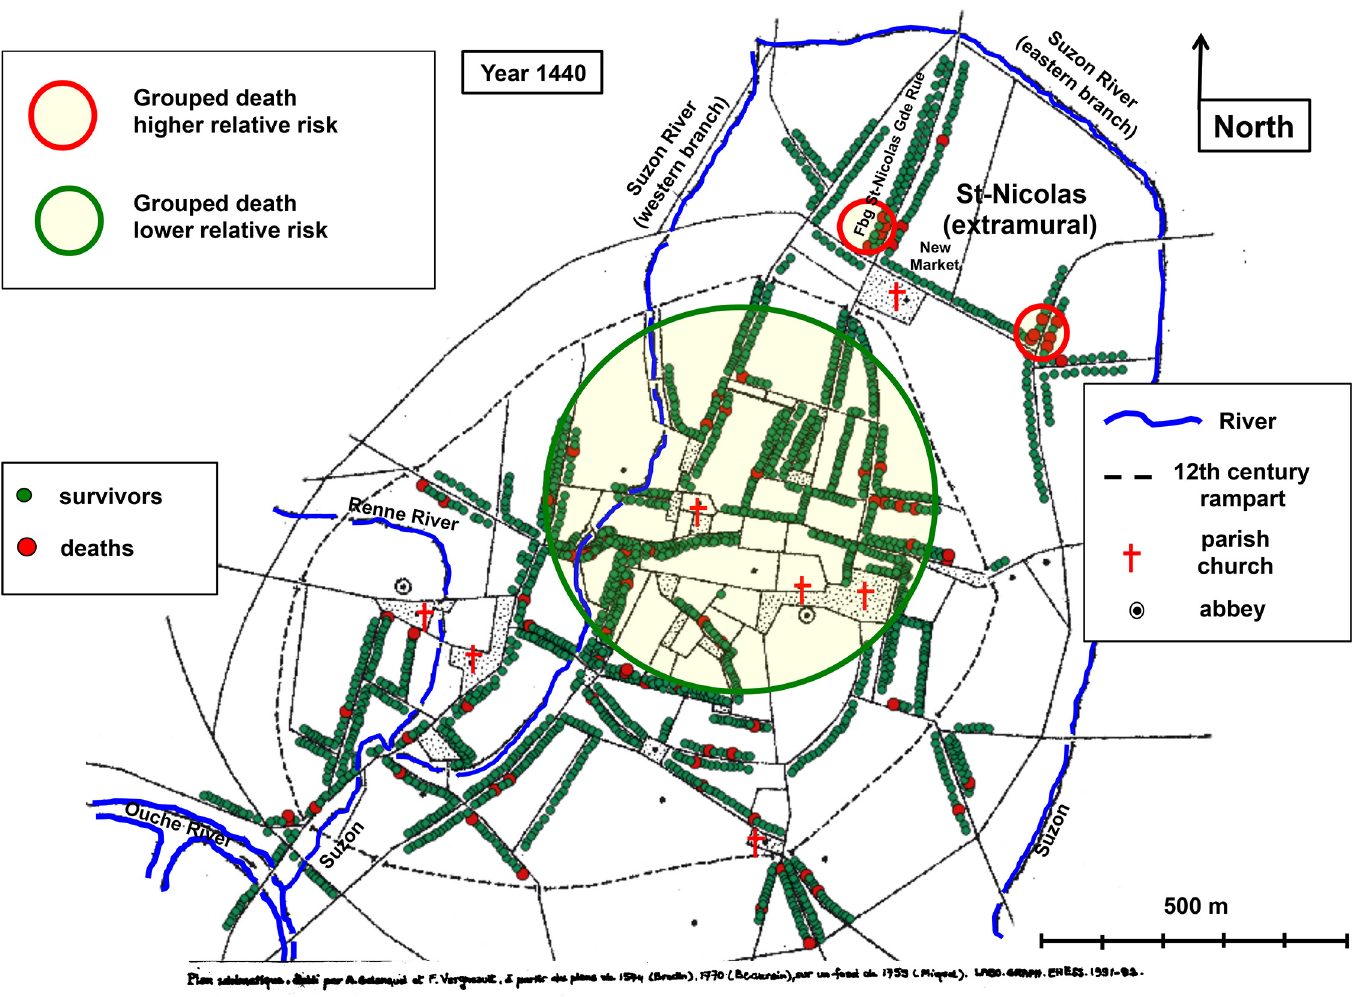
Fig 6. Cartography of death in 1440. Georeferenced map of medieval Dijon. Rivers as blue lines. Parish churches, abbeys and a number of prominent places are indicated. The 12th century rampart is shown by dotted lines. Each point corresponds to a surviving head of household (green points) or to a registered death (larger red points). Yellow areas circled in solid red line: clusters with a higher relative risk of grouped death. Yellow area circled in green: cluster with a null relative risk of grouped death. Historical evidence of the location of the statistically significant clusters is presented in S11 Text